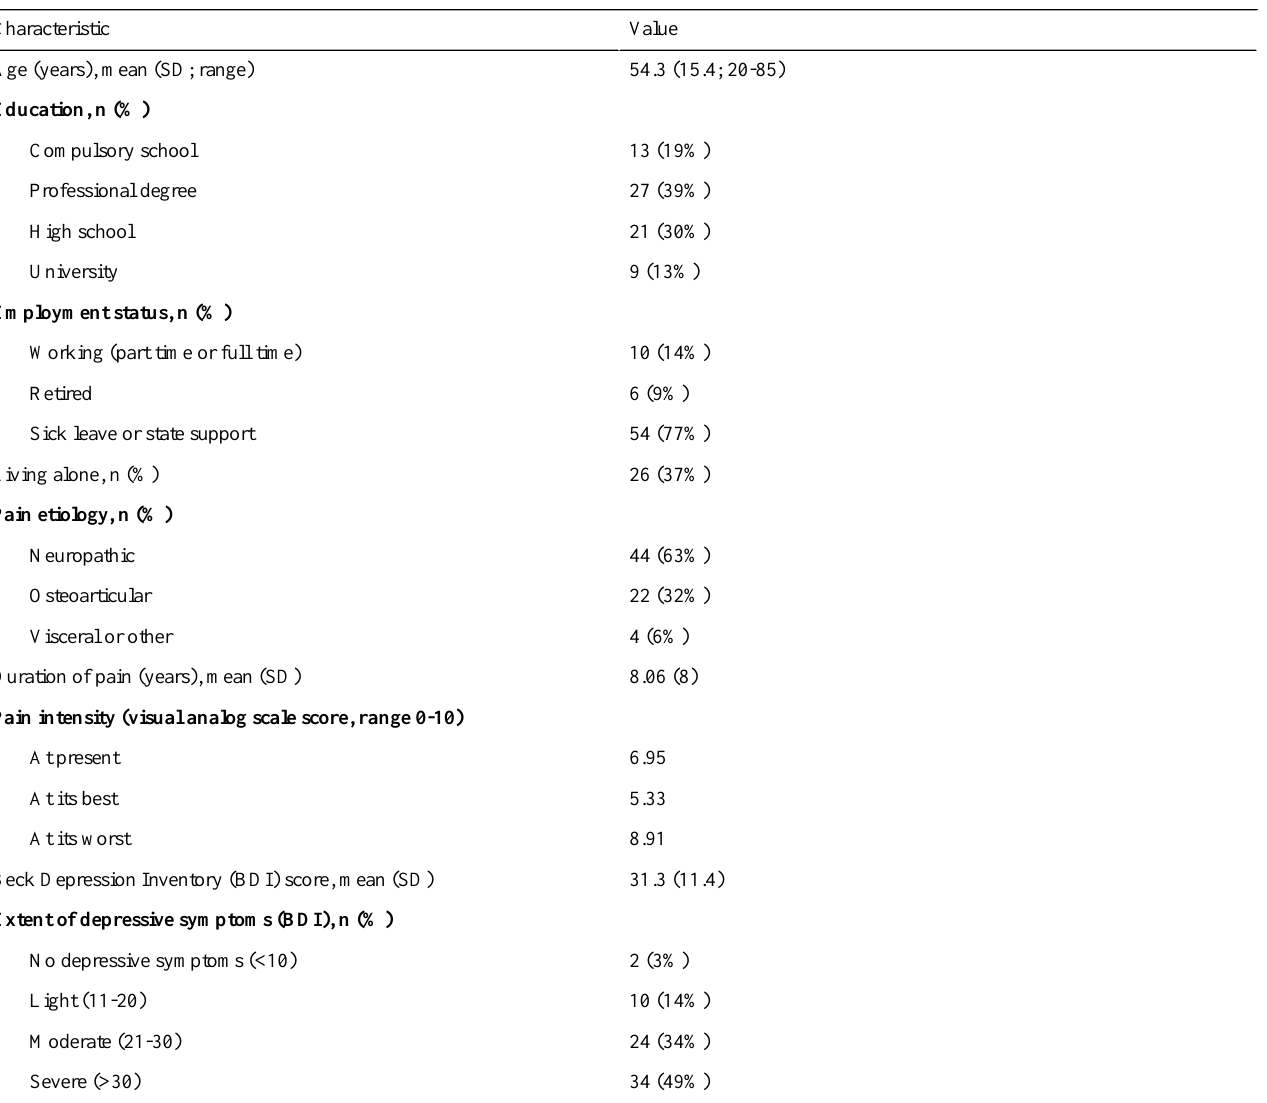
Table 1. Sociodemographic and clinical characteristics of the